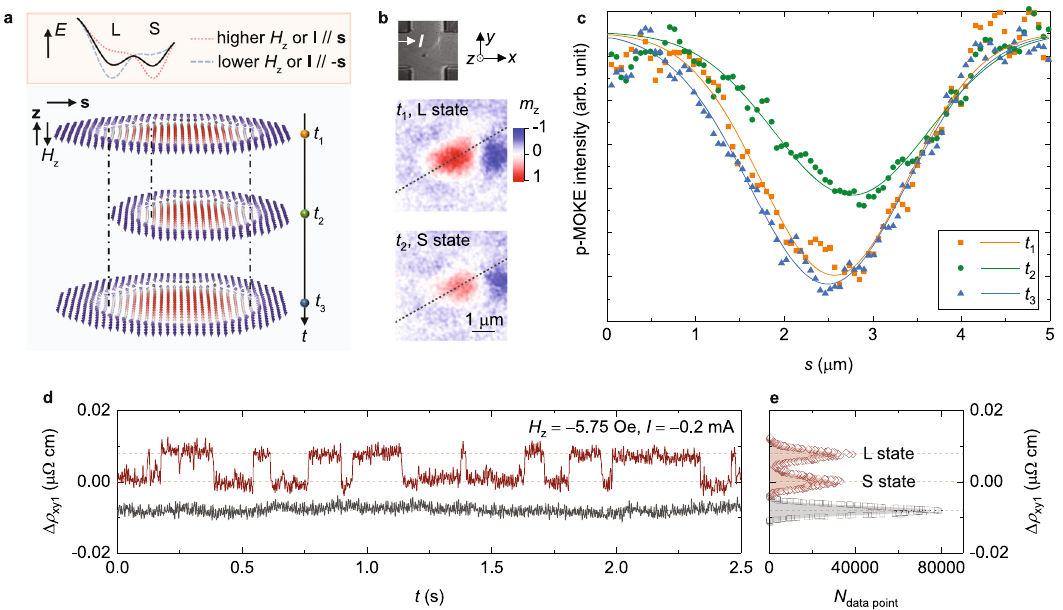
Fig. 1 Local dynamics of a magnetic skyrmion. a Schematic of fl uctuations of an isolated skyrmion interacting with local pinning centres in time between a small-skyrmion (S, at time t 2 ) and a large-skyrmion (L, at times t 1 and t 3 ) state. Blue arrows correspond to downward orientations of magnetization ( − z axis) whereas red arrows represent upward orientations of magnetization ( z axis). The top panel shows a schematic of the energy landscape between two skyrmion states separated by an energy barrier which can be tuned by modifying the applied magnetic fi eld H z and the electric current I . b Polar- magneto optic Kerr effect microscope (p-MOKE) images of the two states of an isolated skyrmion. c P-MOKE signals along dotted lines in b ( s increases from the left to right). Solid curves are fi ts to Gaussian functions. d Relative Hall-resistivity ( Δ ρ xy1 ) variations in time for a single skyrmion (upper) and a ferromagnetic state (bottom). e Statistics of data point distributions ( N data point ), open dots) as a function of Δ ρ xy1 . Open dots are fi tted to Gaussian functions. All results are measured at 307.1 K and a current I = − 0.2 mA. Results for the skyrmion in b – d are measured at H z = − 5.75 Oe and for the ferromagnetic state at H z = − 5.89